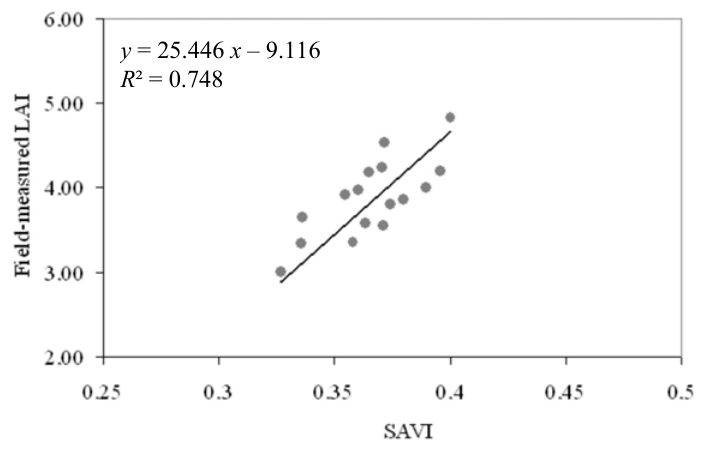
Figure 6. Validation of AVHRR LAI product at the Almaty forest test site. ( a ) Relationship between field-measured LAI and the Landsat ETM+-derived SAVI. ( b ) Pixel-by-pixel comparison of the aggregated fine-resolution LAI map and the AVHRR LAI product. ( c ) Frequency distribution of the Landsat ETM+ regression-based LAI and AVHRR